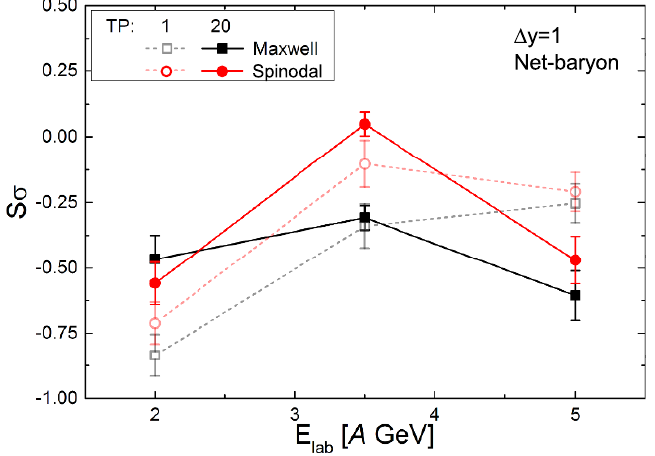
Figure 12 . The normalized skewness of the net baryon number distribution in the rapidity window of (cid:0) 0 : 5 < y < 0 : 5 for several incident beam energies (in the lab frame). Results for TP=1 and TP=20 are compared. A peak is found for the beam energy that produces the largest e(cid:11)ect of the spinodal